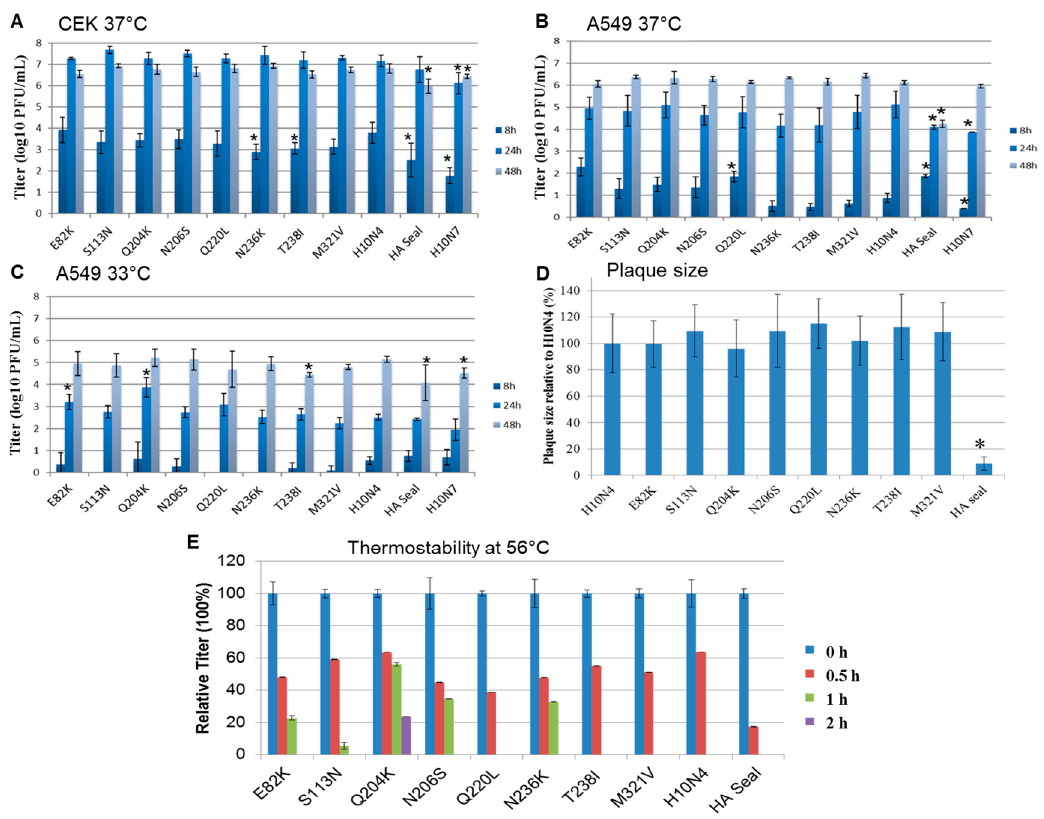
Figure 3. Replication kinetics and cell-to-cell spread of recombinant H10 viruses. Shown are the averages and standard deviations of replication kinetics of indicated viruses in ( A ) primary chicken embryo kidney cells at 37 °C and ( B ) human lung adenocarcinoma cells at 37 °C and ( C ) 33 °C at 8, 24, and 48 h postinfection. Cell-to-cell spread was assayed by measuring 50 to 100 plaques in MDCKII cells; ( D ) results are expressed as percentage of the average diameter of plaques induced by H10N4. Statistically significant values compared to the H10N4 virus are shown by asterisks. Thermostability of 10 5 plaque-forming units (PFU) of each virus was determined after incubation at 56 °C for 4 h. The test was conducted in duplicate and repeated twice, and the virus titer was determined by plaque assay in MDCKII cells. All viruses were inactivated after 2 h; ( E ) shown are the relative titers at each indicated time point compared to titers before inactivation.